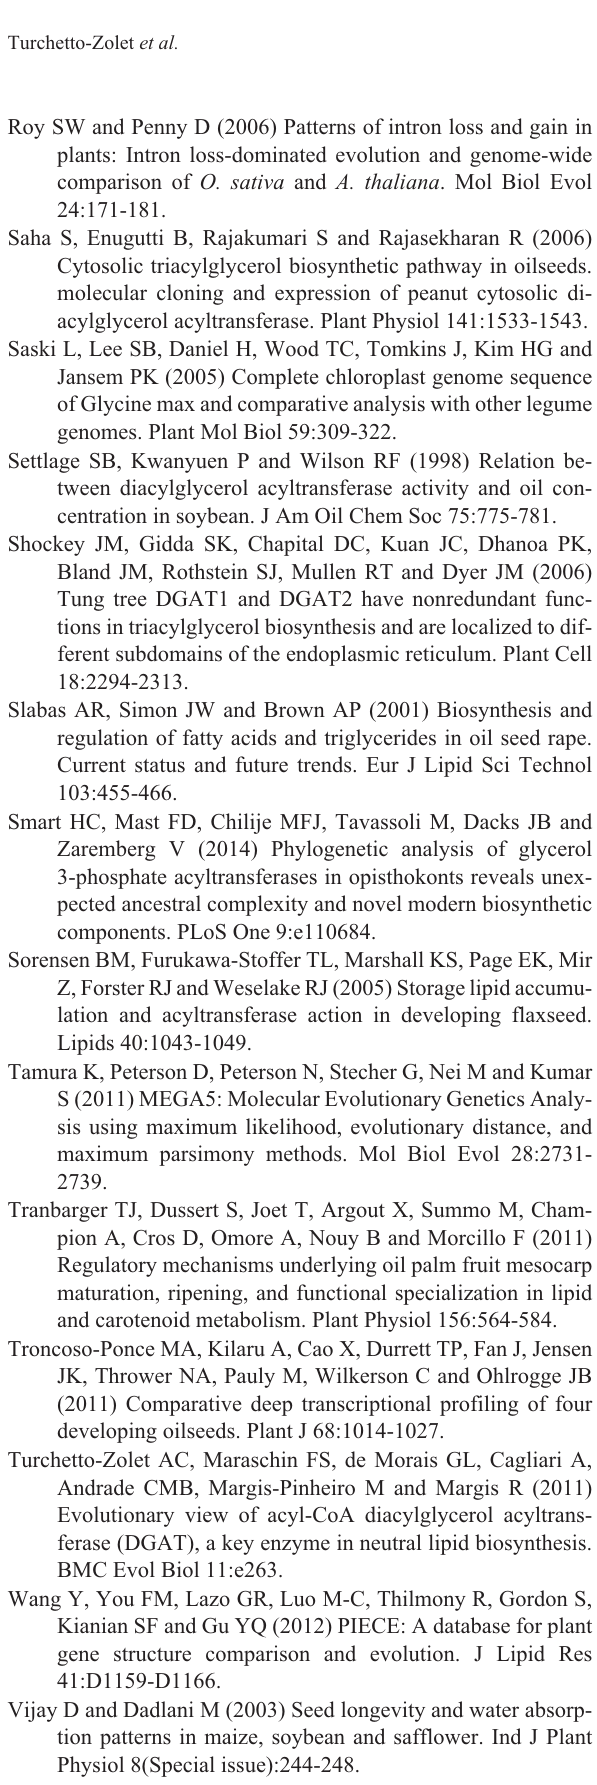
Table S1: Species, gene name, accession numbers and pro- tein length of DGAT sequences retrieved in this study. Table S2: Primers used in this